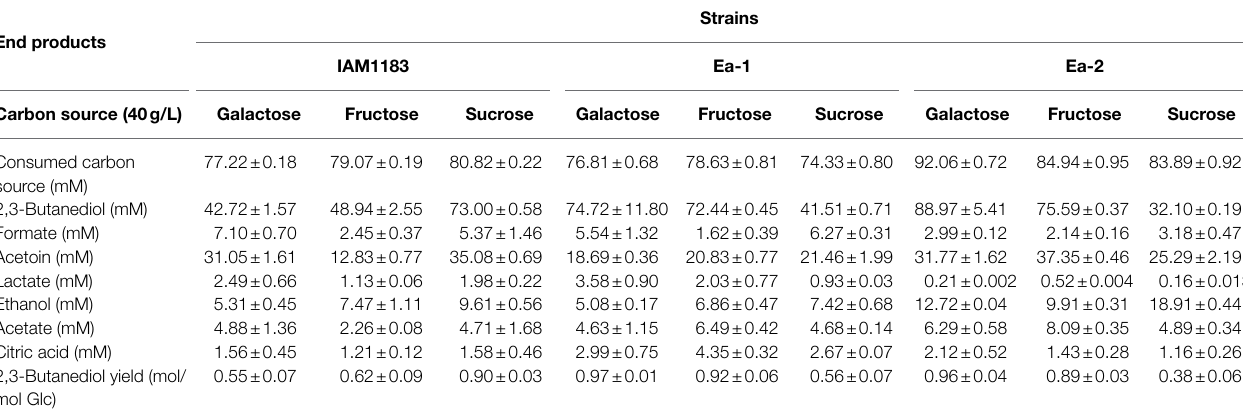
TABLE 3 | Comparison of wild-type E. aerogenes IAM1183 with the mutants Ea-1 and Ea-2 grown for 20 h in shake-flask cultures on different carbon sources ( n = 3).